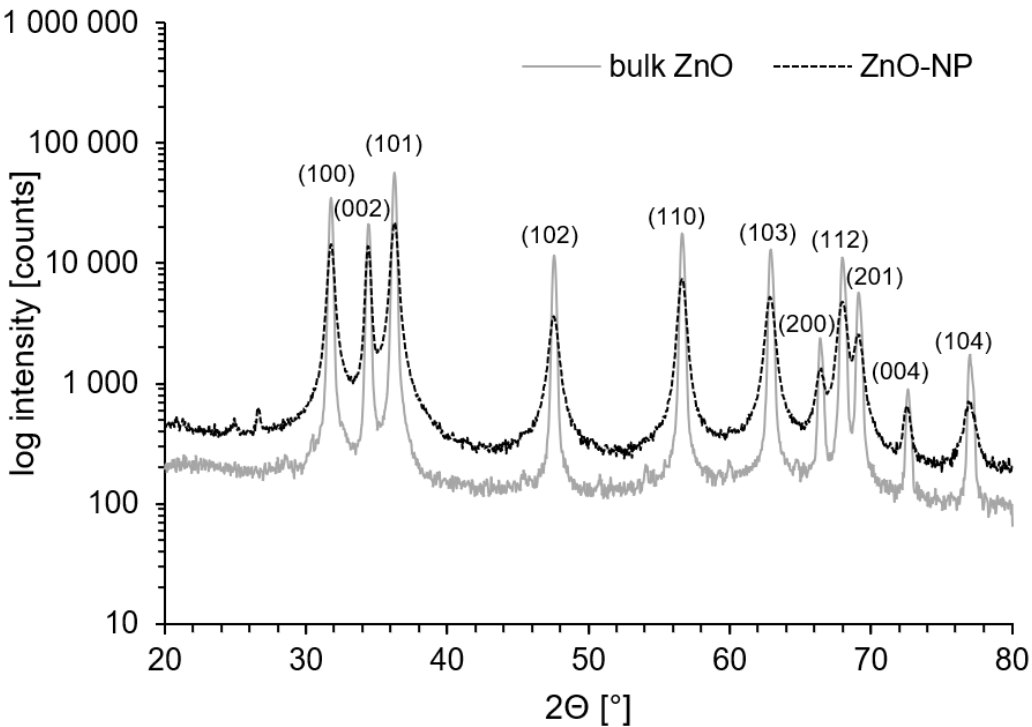
Figure 1. X-ray powder diffraction (XRD) spectrum pattern of nanoparticles (black line) compared to XRD spectrum of bulk ZnO (grey line). The peaks are typical for the mineral zincite with wurtzite structure. A broadening of the diffraction peaks in ZnO-NP diffractogram indicates that investigated material is in nanometer scale.